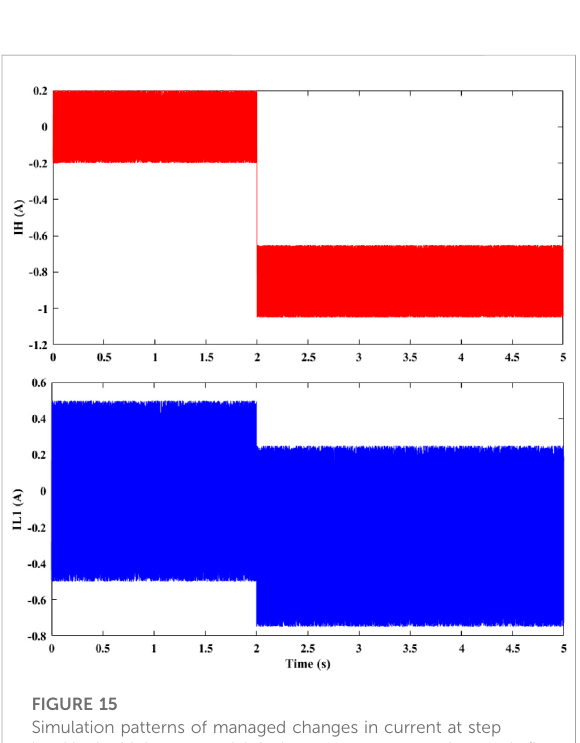
switches (S, Q 1 -Q 4 ) using PI or more complex approaches.